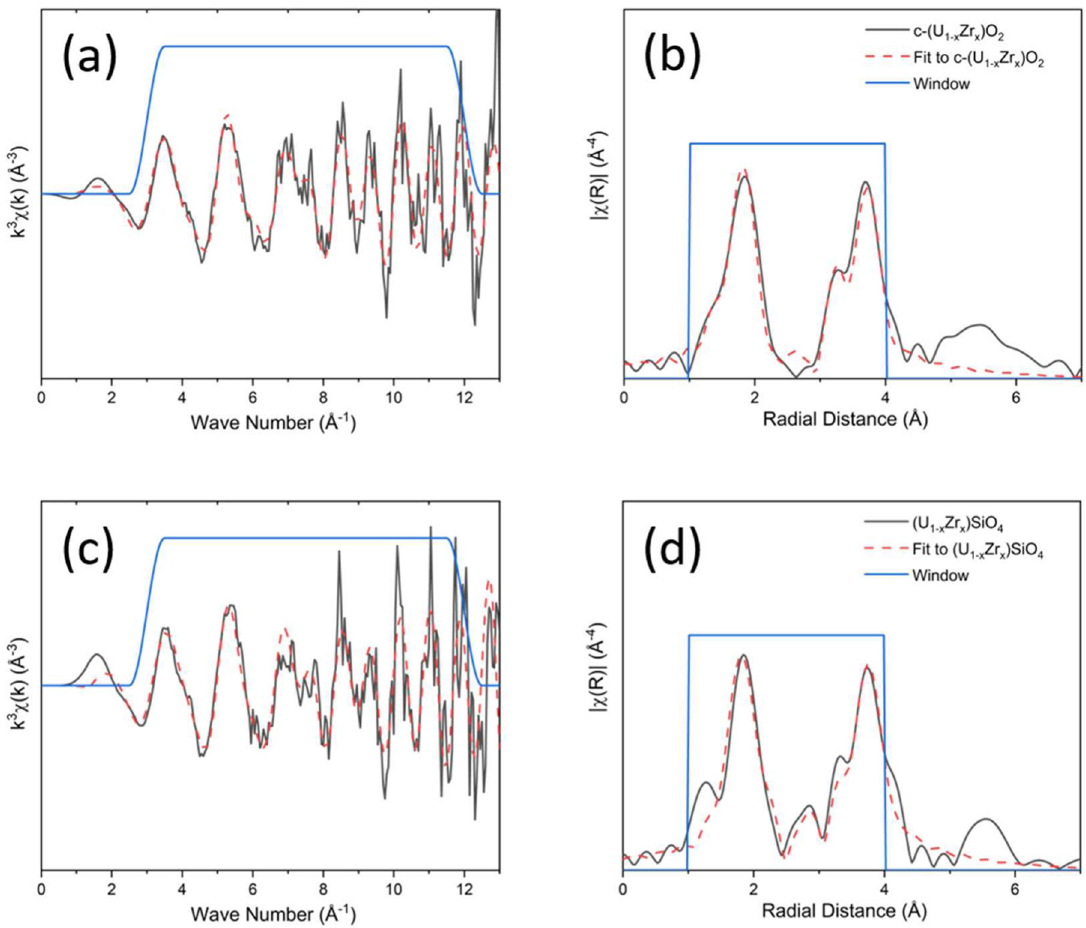
Fig. 8 Local coordination analysis of U in simulant MCCI-3 determined by μ -EXAFS analysis. Showing the U L 3 spectra and model fi t of a (U,Zr)O 2 k 3 - weighted μ -EXAFS and b μ -EXAFS in radial space; and c (U,Zr)SiO 4 k 3 - weighted μ -EXAFS and d μ -EXAFS in radial